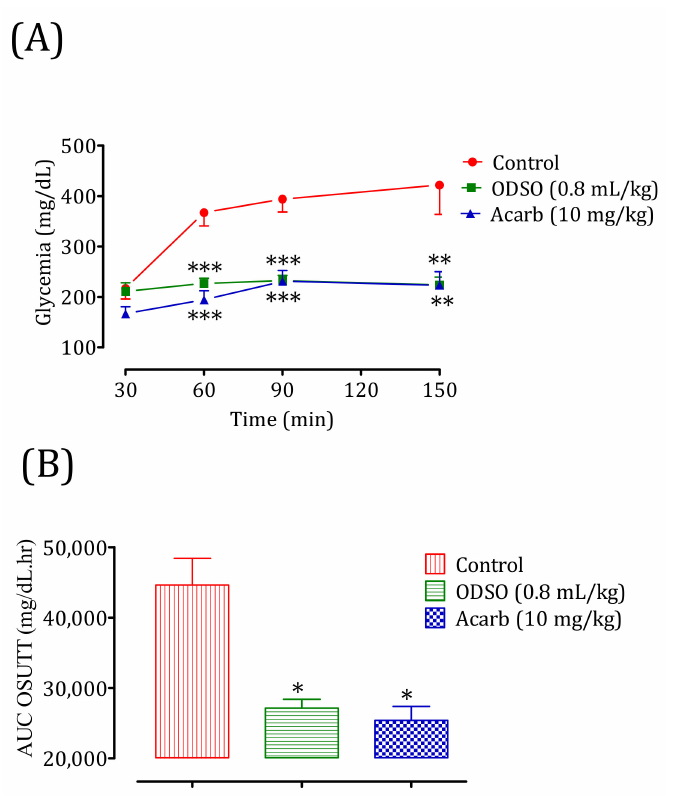
Figure 12. Effect of oil (ODSO) and acarbose (Acarb) on the change in the postprandial glycemia in diabetic rats ( A ), with a representation in the form of the area under the curve ( B ). The values are the means ± SEM ( n = 6). * p < 0.05, ** p < 0.01, and *** p < 0.001 compared to the